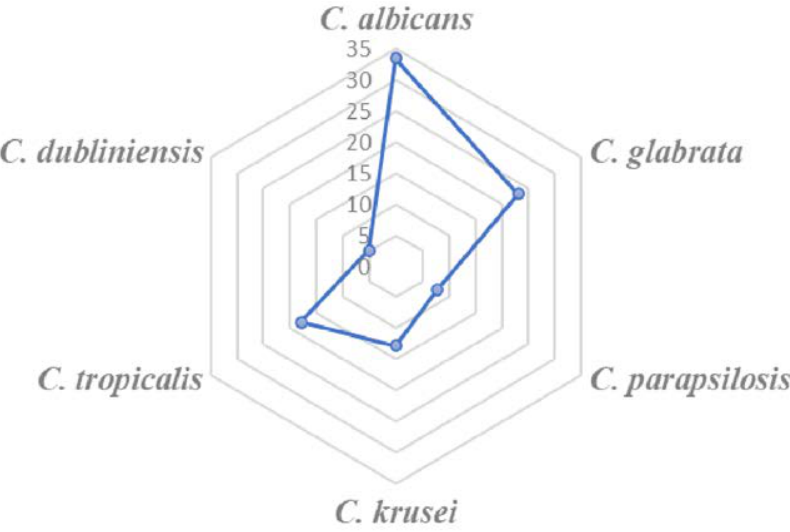
Fig. 1. Percentage Occurrences of Candida Isolates in Urine Samples of Diabetic Table 4. Distribution of Candida Isolates Based on Age, Gender and RBS Values of Diabetic (Candiduric) Patients No of No (%) of Occurence Candida Isolates Isolates